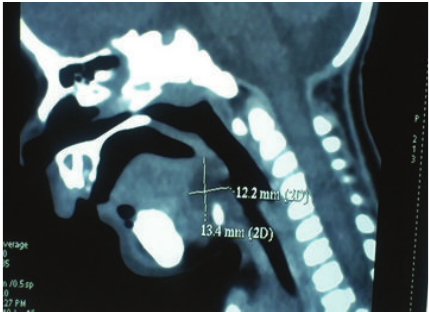
Figure 3: Preoperative endoscopic view of cystic mass of the tongue mass of case I.